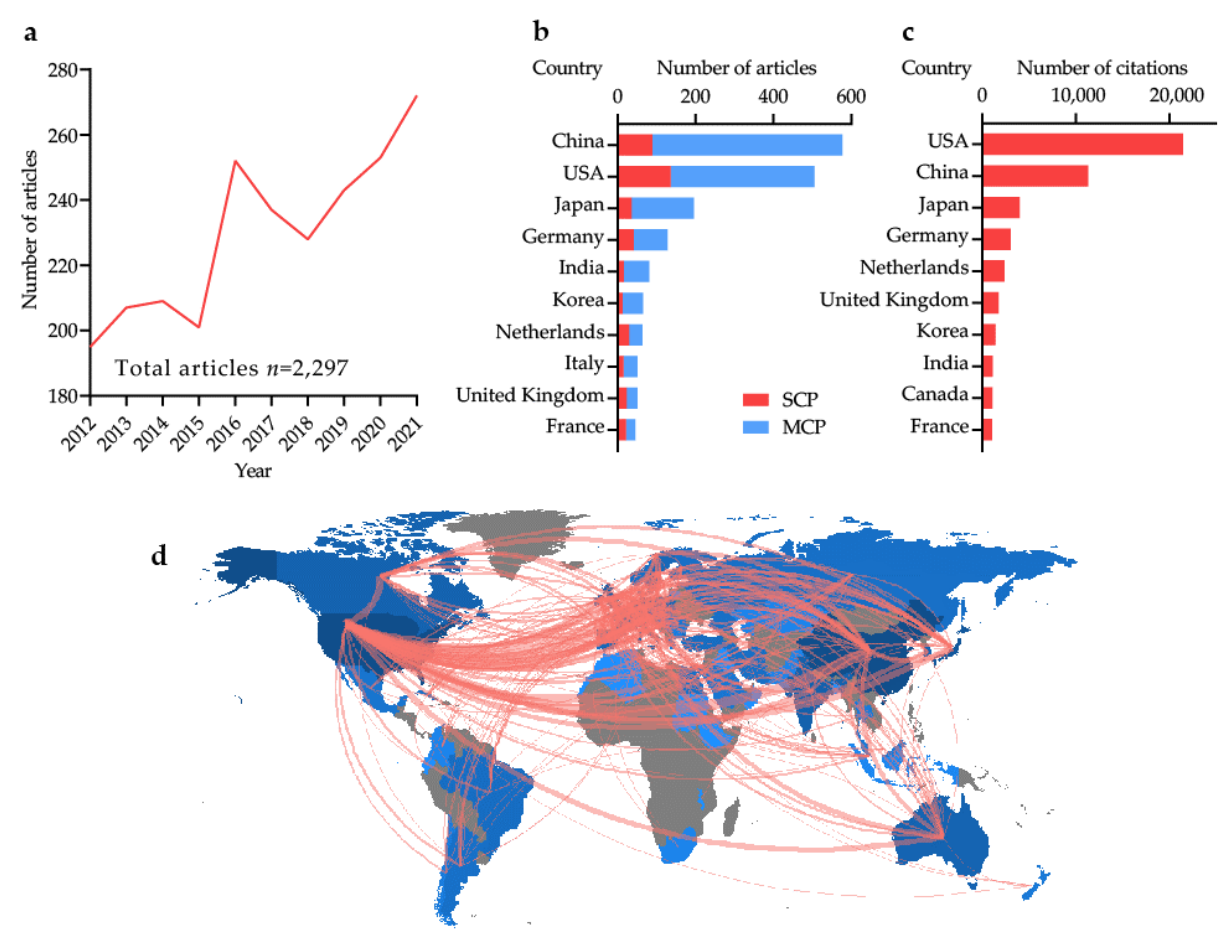
Figure 1. Global trends in publications on cancer sialylation: ( a ) the annual publications over the past decade; ( b ) top 10 countries with the most articles. SCP: single country publications; MCP: multiple country publications; ( c ) top 10 countries with the most total citations of related articles; and ( d ) world map showing collaborations between different countries in this field. The figures were plotted automatically using the bibliometrix package in R version 4.2.0 based on the retrieved articles.